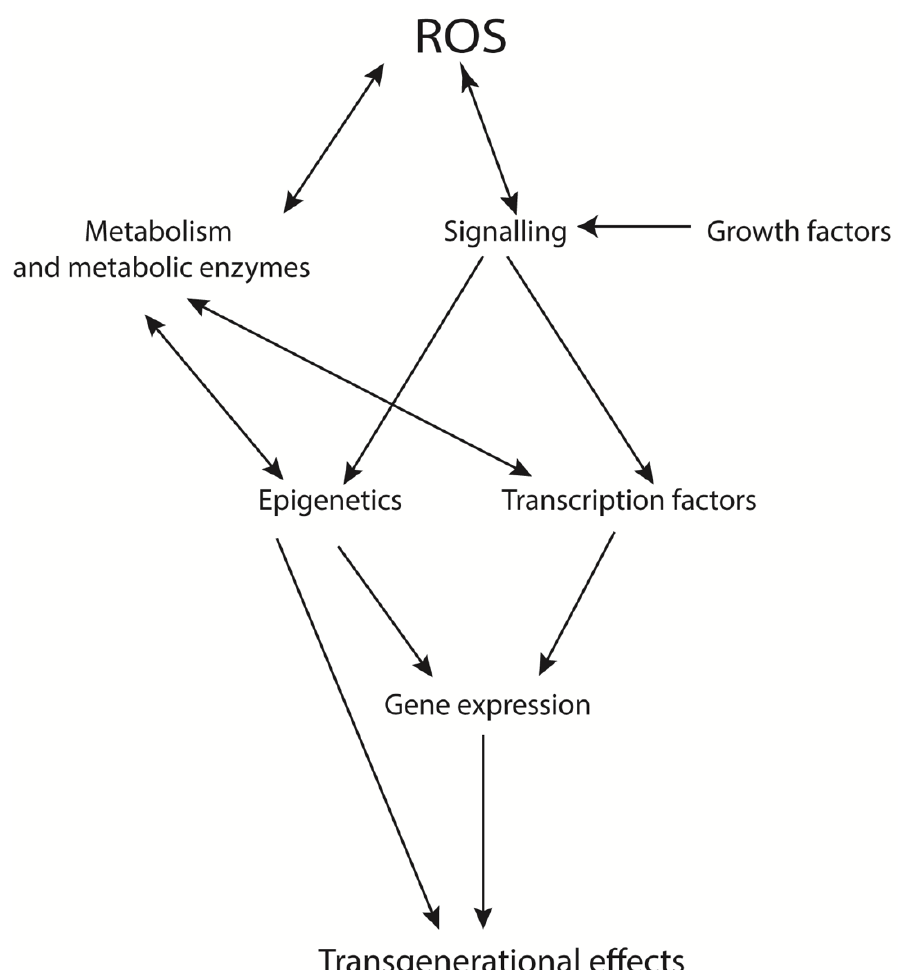
Figure 1. Effects of ROS on cellular function. ROS production has a multitude of impacts on cellular function and can act in both a beneficial and deleterious manner. ROS are produced as a ‘by-product’ of cellular metabolism and as a result of various cell-signalling pathways, including many activated by growth factors. They can also directly affect the activity of signalling pathway components and metabolic enzymes, leading to changes in cellular metabolic profile and energy usage. In turn, these changes in metabolism and signalling can lead to changes in the epigenetic landscape and the activity of transcription factors, altering gene expression. Since these events directly and indirectly affect the reproductive system, transgenerational effects resulting from normal and aberrant ROS production can and do occur.